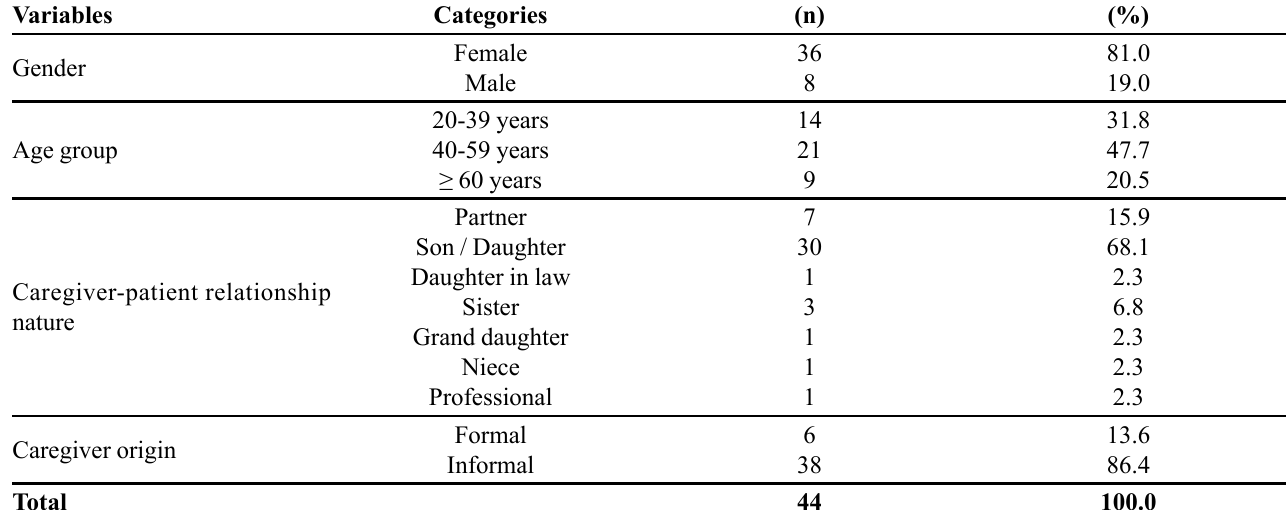
TABLE I – Description of caregivers of elderly individuals with dementia assisted by MEC, December 2013